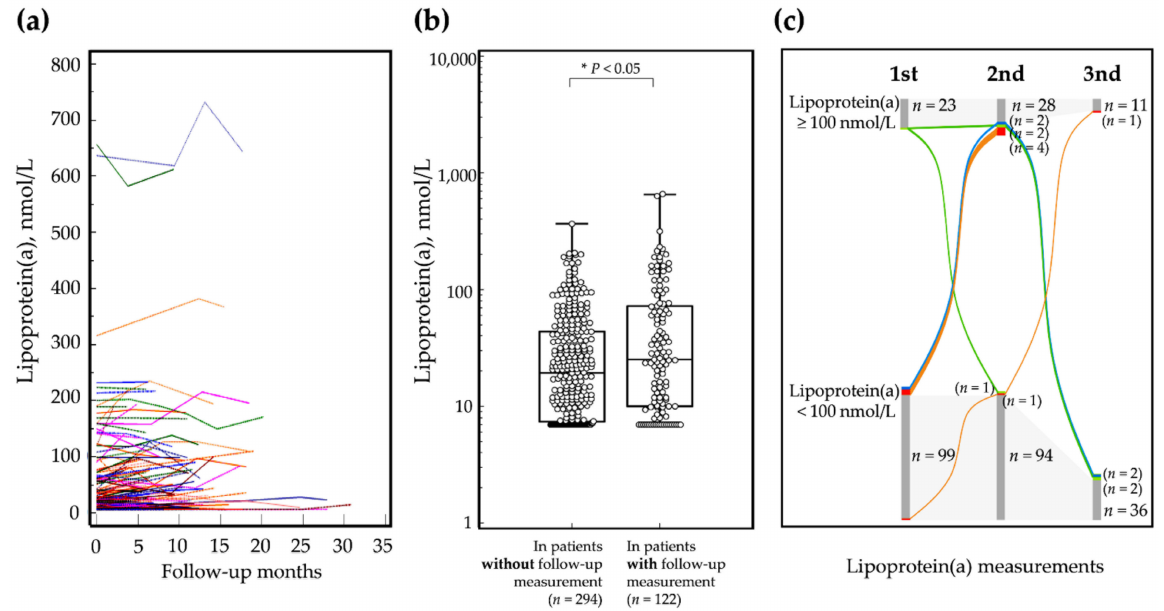
Figure 1. Distribution of serum lipoprotein(a) levels in a Korean pediatric population ( n = 416).